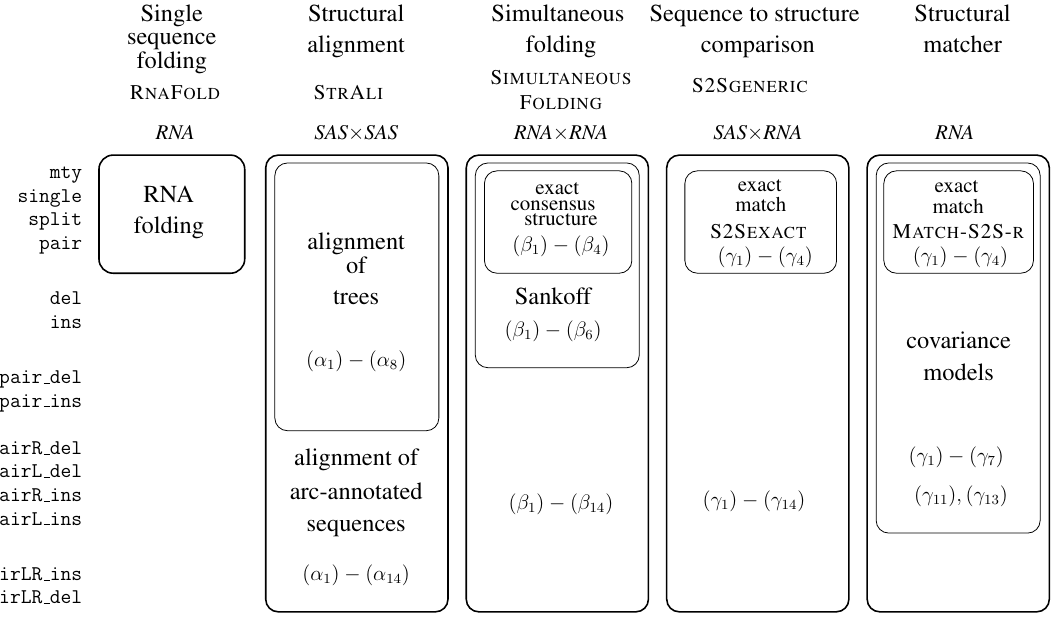
Figure 8. Overview of all RNA related problems adressed in Section 6. These problems are classified according to the edit operations they use (column on the left) and to the kind of inputs. For each problem, we indicate meaningful restrictions that are detailed in the